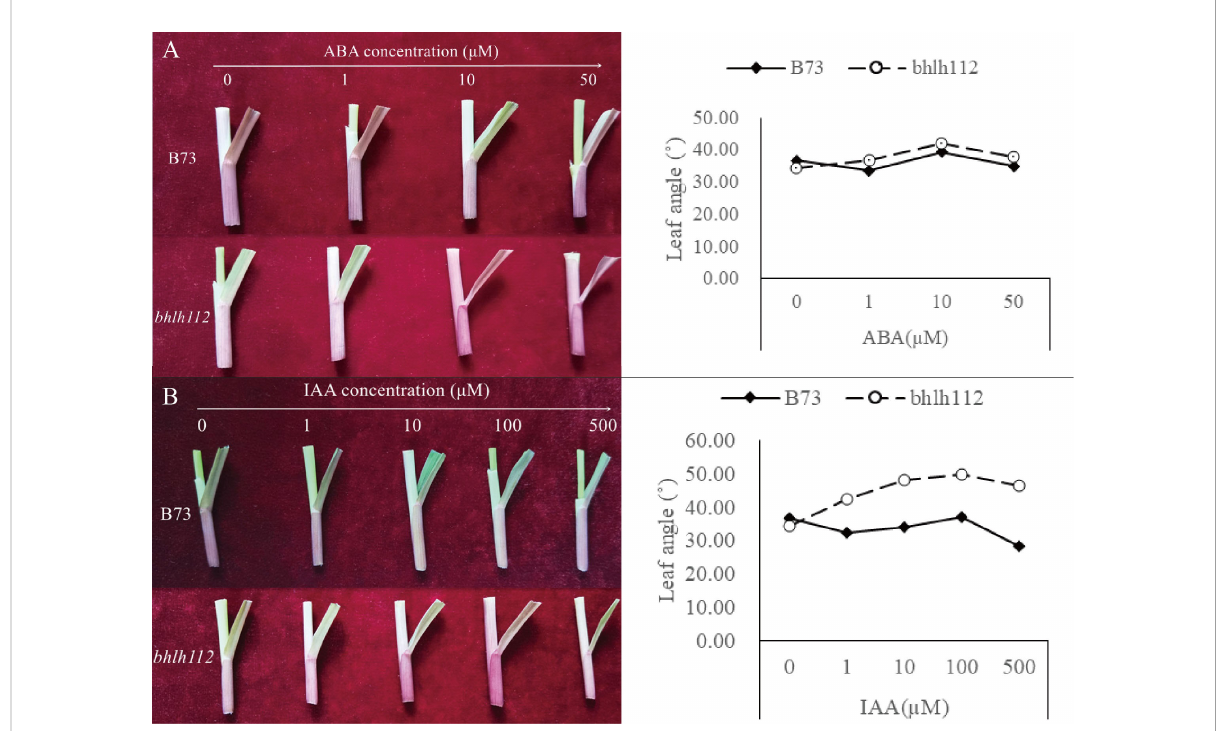
FIGURE 3 Effects of ABA and IAA on leaf angle in maize. (A) Changes in leaf angle from different concentrations of ABA in mutant and wild-type V3 stage. (B) Changes in leaf angle from different concentrations of IAA in the mutant and wild-type V3